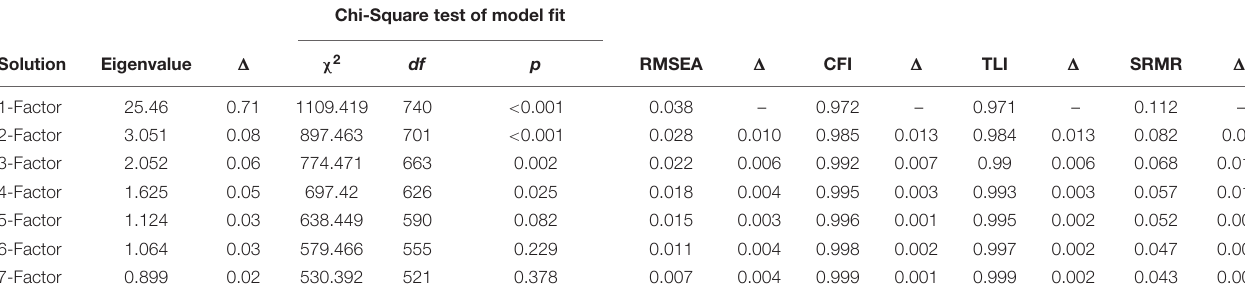
TABLE 3 | Exploratory factor analysis (EFA) model fit indices for the factor structure of the Teen Dating Aggression Measure (TeDAM). Chi-Square test of model